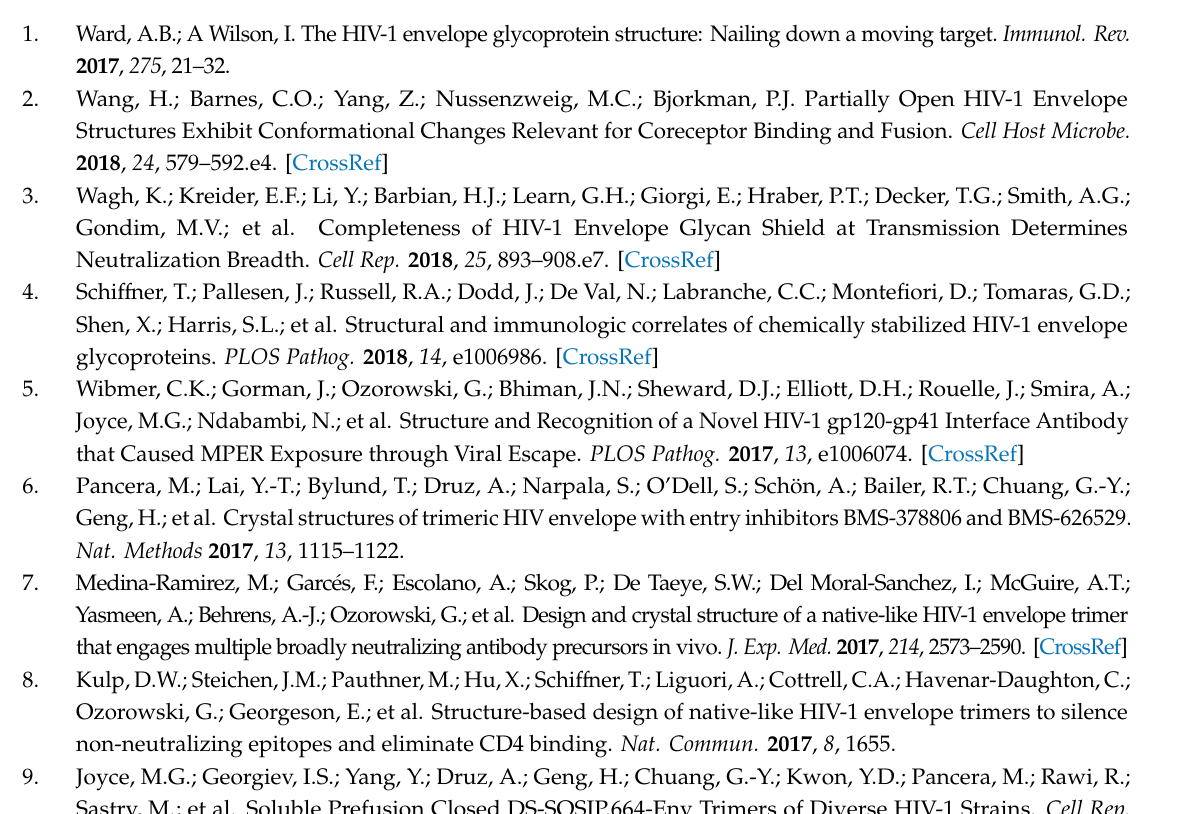
Supplementary Materials: The following are available online at, Figure S1: Single round infection assay graphs, Figure S2: Toxicity of compounds, Figure S3: Sensorgram of SC56 , Table S1: NS-EM